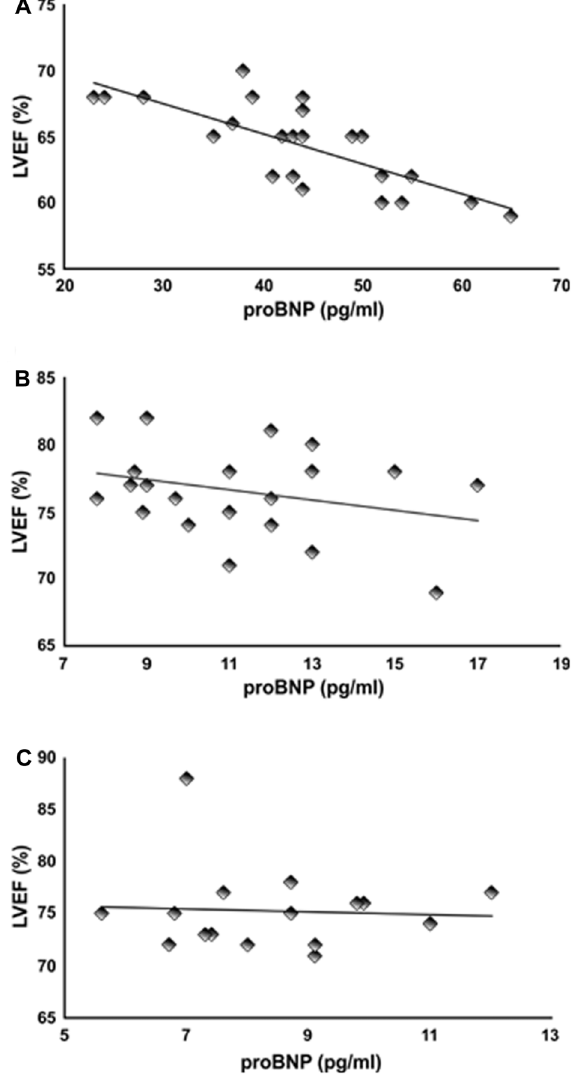
Figure 4. Pearson’s correlation (r) between measures of left ventricular ejection fraction (LVEF) and pro-B-type natriuretic pep- tide (proBNP) in the groups treated with chemotherapy alone ( A ), chemotherapy followed by tamoxifen ( B ), and tamoxifen alone ( C